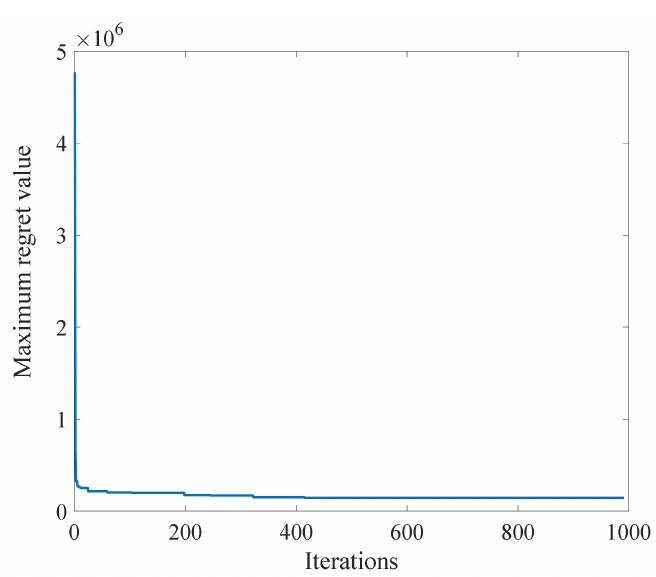
Figure 8. Convergence graph of maximum regret